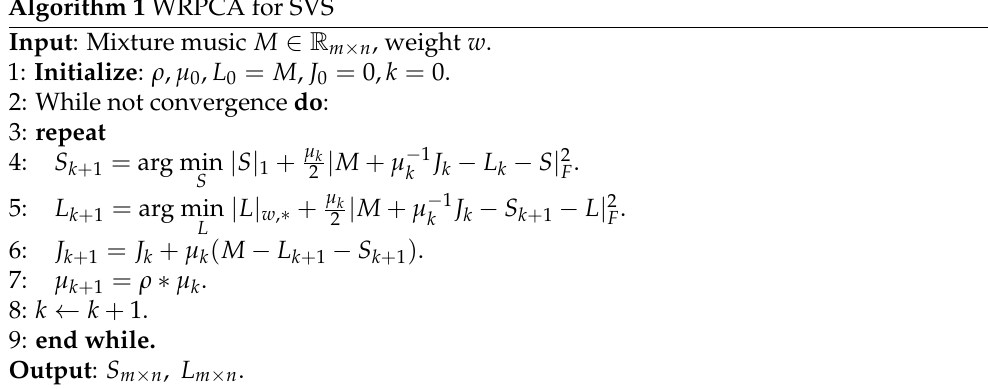
Algorithm 1 WRPCA for